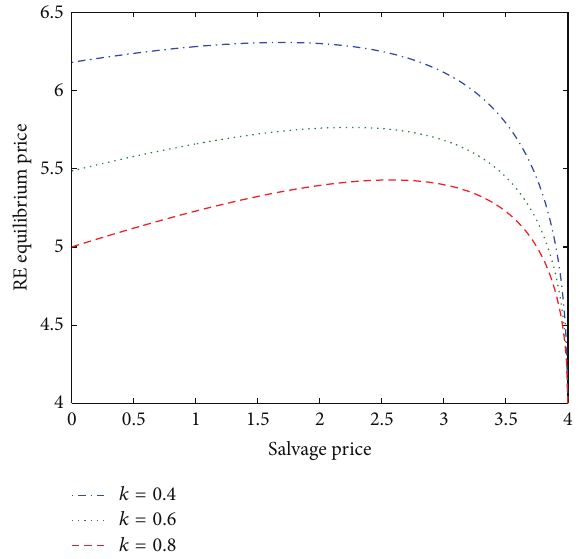
Figure 4: The effect of salvage price on 𝑝